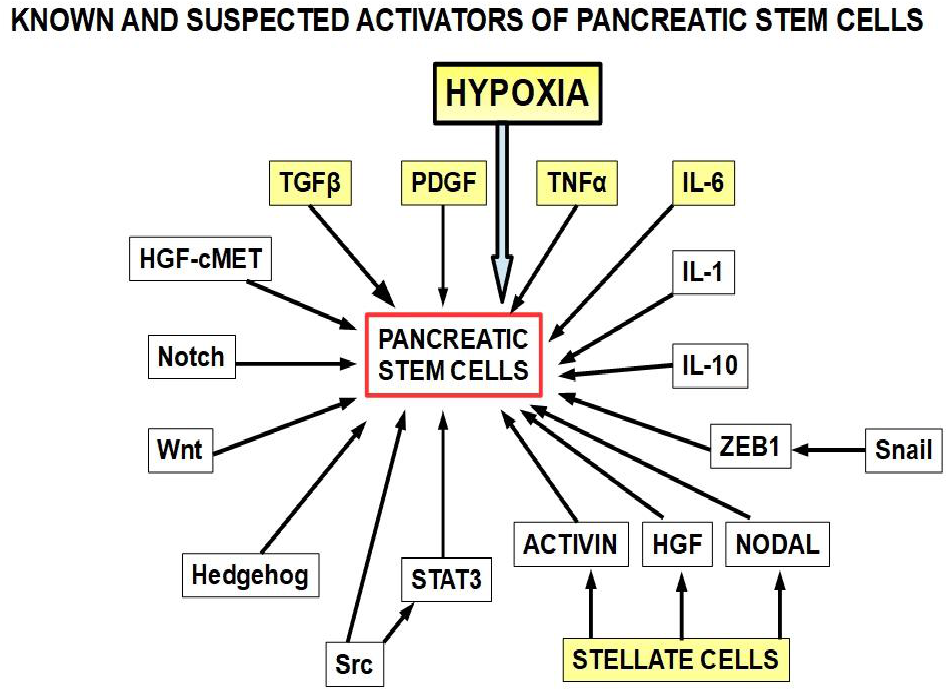
Figure 10. The yellow squares are the known activators of pancreatic cancer stem cells. The other activators (white squares) have also been found to play a role. This diagram is based on references [382–401]. Importantly, many of the stemness activators are also involved in epithelial–mesenchymal transition.